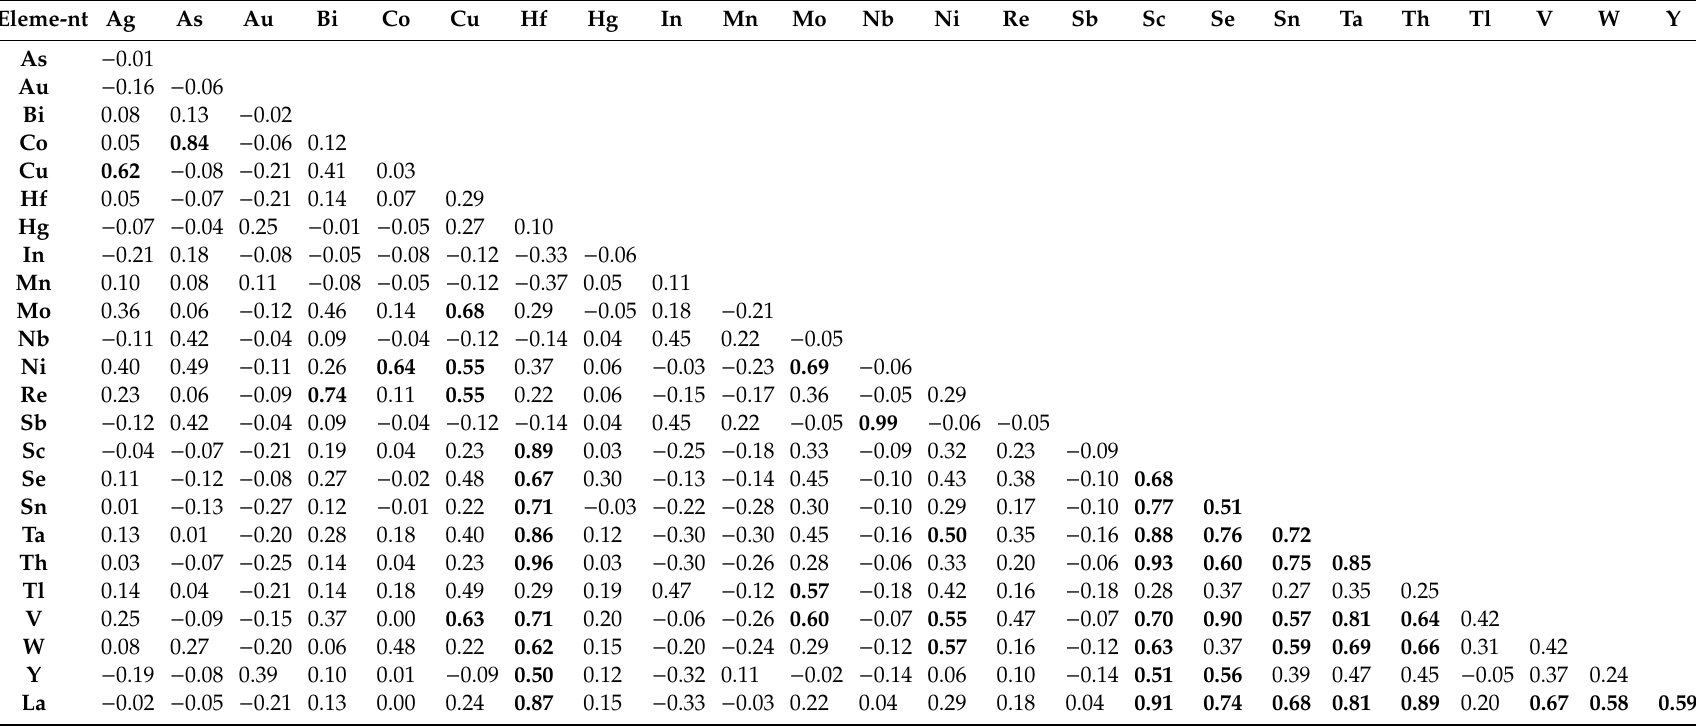
Table 7. Pearson’s correlation coe ffi cients of selected elements for the bulk-rock analyses of Cu-Ag ores from the Kupferschiefer deposits in